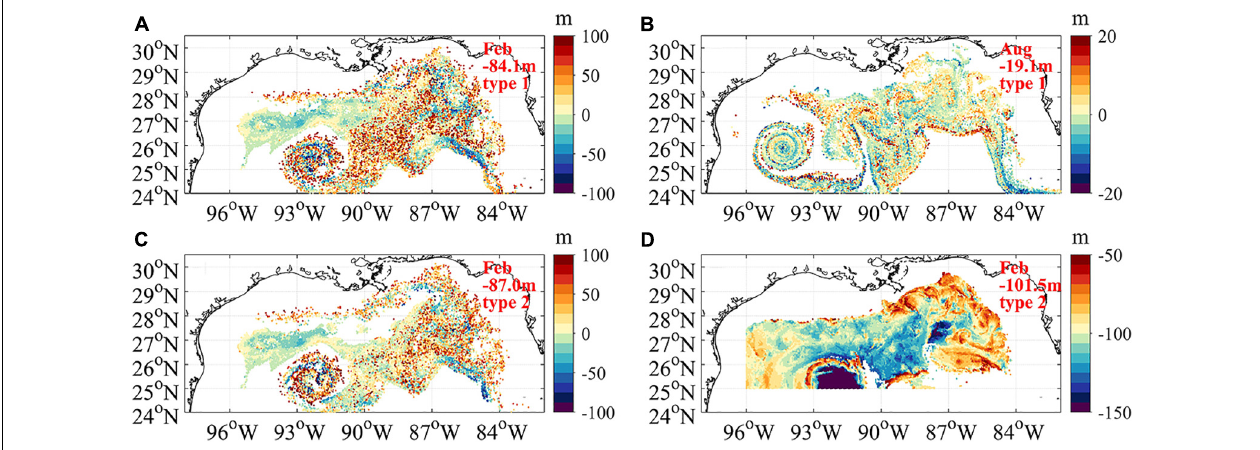
FIGURE 6 | Distributions of depth changes for “deep” Lagrangian particles after 10 days in the SP simulation in February [ (A) : release type 1 , initial depth 100 m] and August [ (B) release type 1 , initial depth 20 m]. Positive values indicate upwelling. (C) : distribution depth changes for type 2 particles, always after 10 days and (D) : the initial depth of the type 2 particles in panel (C) . Particles that have traveled horizontally more than 300 km have been removed. The mean depth of the particles on day 10 is also indicated. The particles plotted are from the first release in winter and